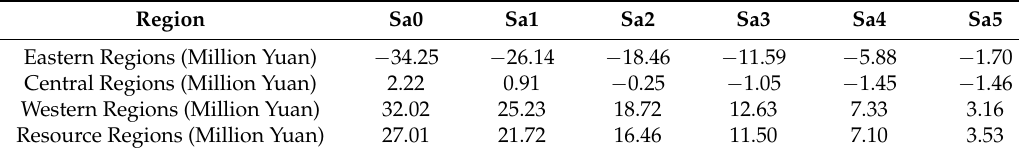
Table 5. Inter-regional flow of carbon trading funds under different scenarios.